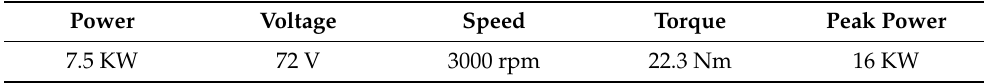
Table 4. Electric motor inverter specification (rated).